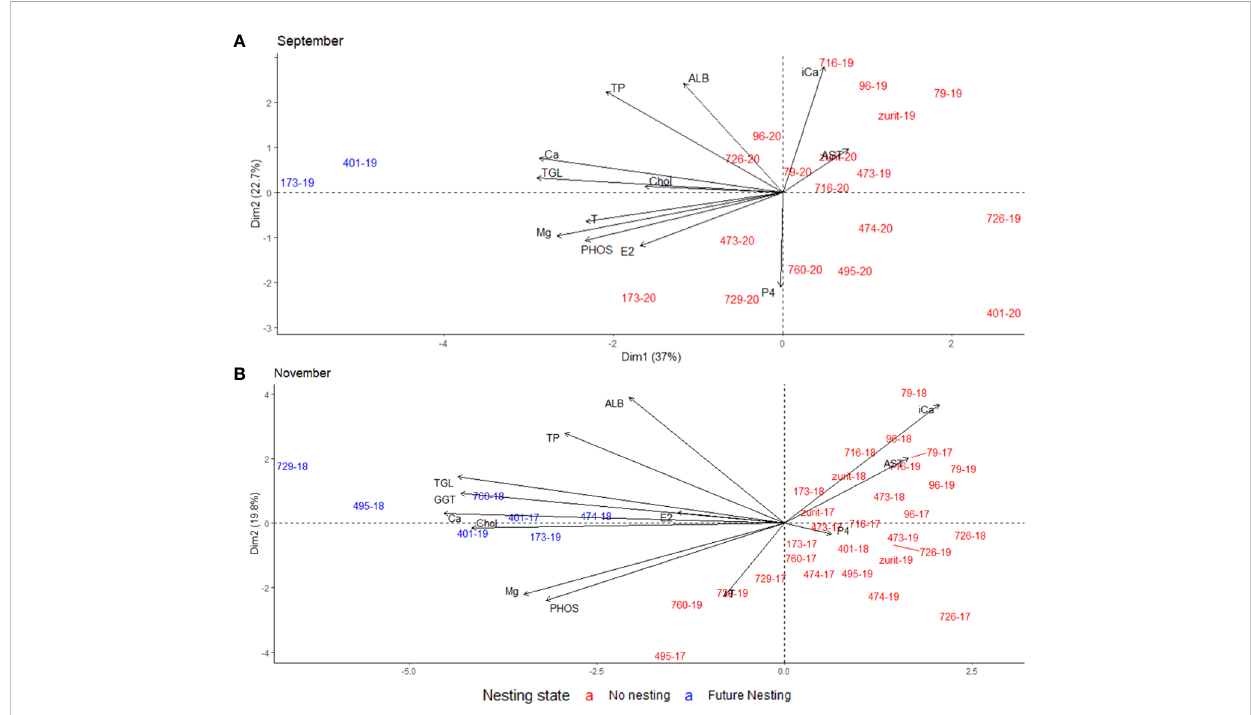
FIGURE 5 Graphical representations of PCA including 12 blood parameters tested in September (A) and November (B) of two nesting cycles (2018-2020). Each individual sample positioned within the PC axes represented with green turtle female`s ID and the sampled year divided by `-`. The color indicating that individual ’ s nesting status, future nesting (blue) or non-nesting (red).